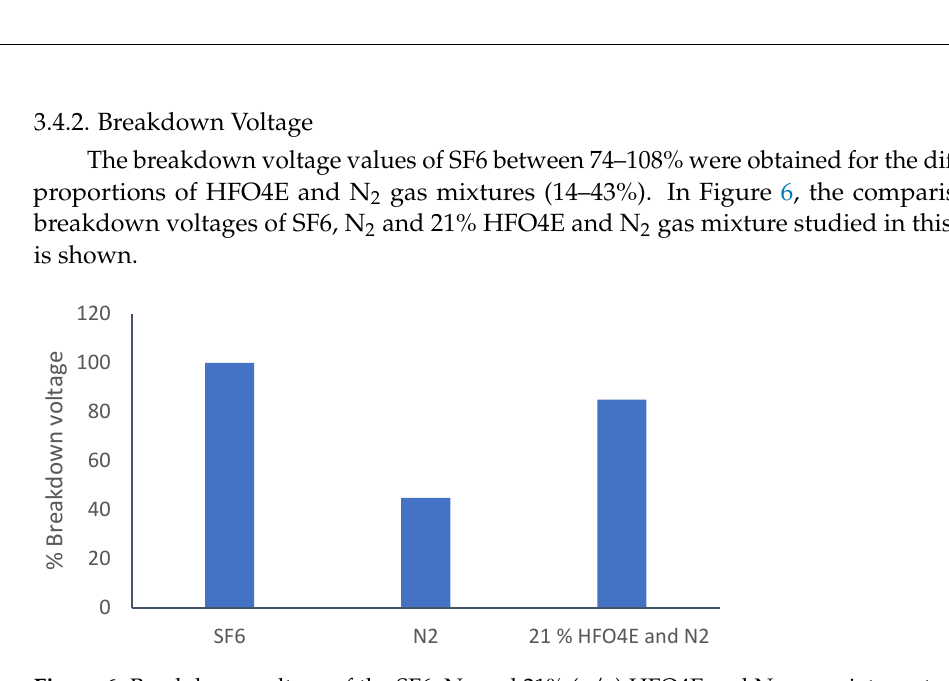
Figure 6. Breakdown voltage of the SF6, N 2 and 21% ( v / v ) HFO4E and N 2 gas mixture studied in this work.